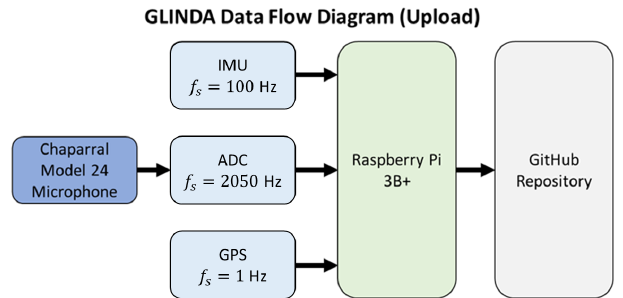
Figure 3. Flowchart for acquiring and uploading of data from GLINDA.